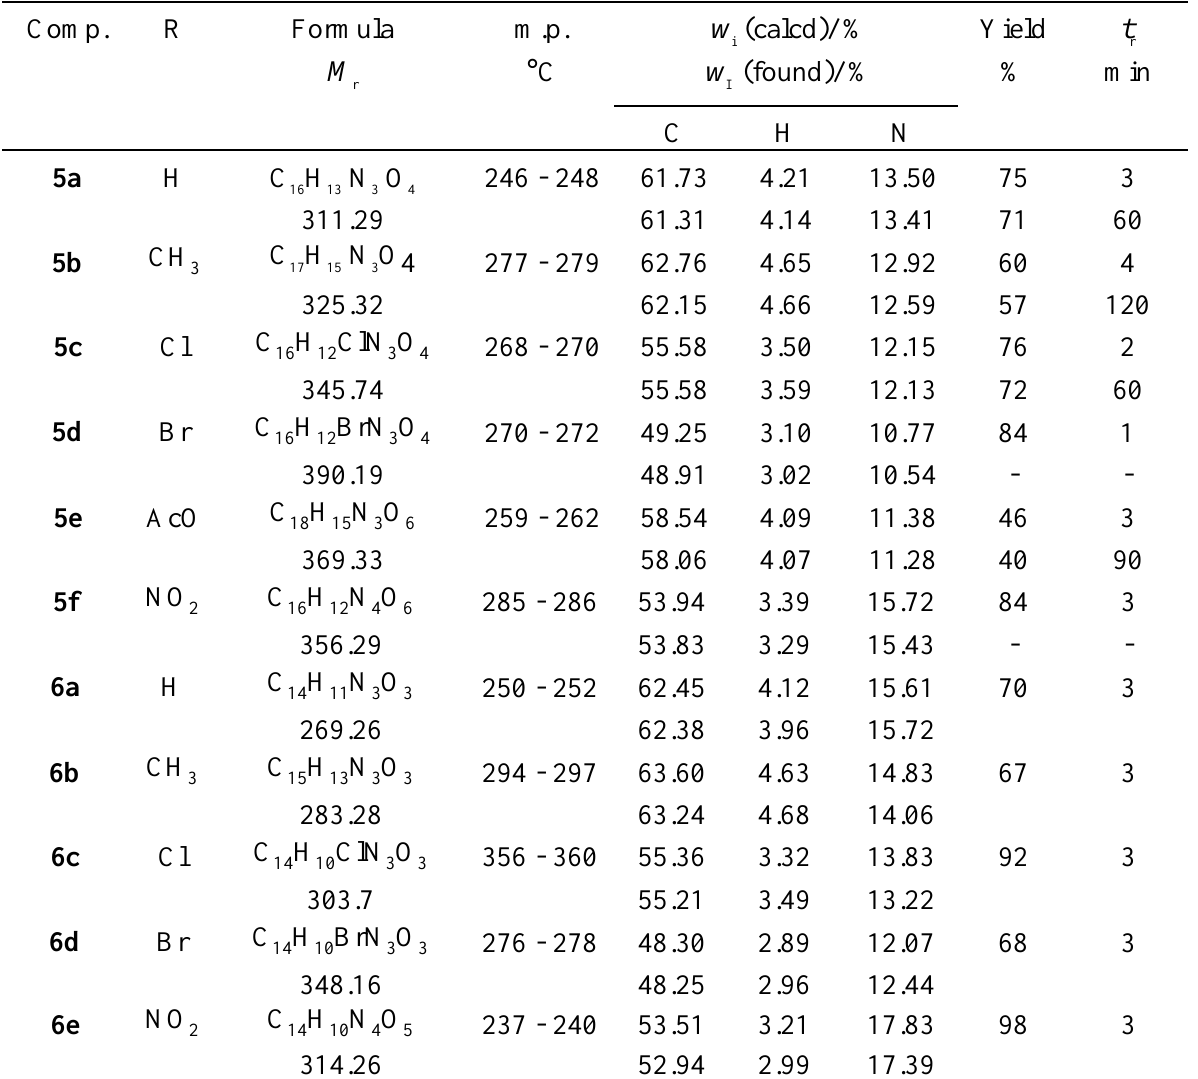
Table 1. Characterization of the prepared